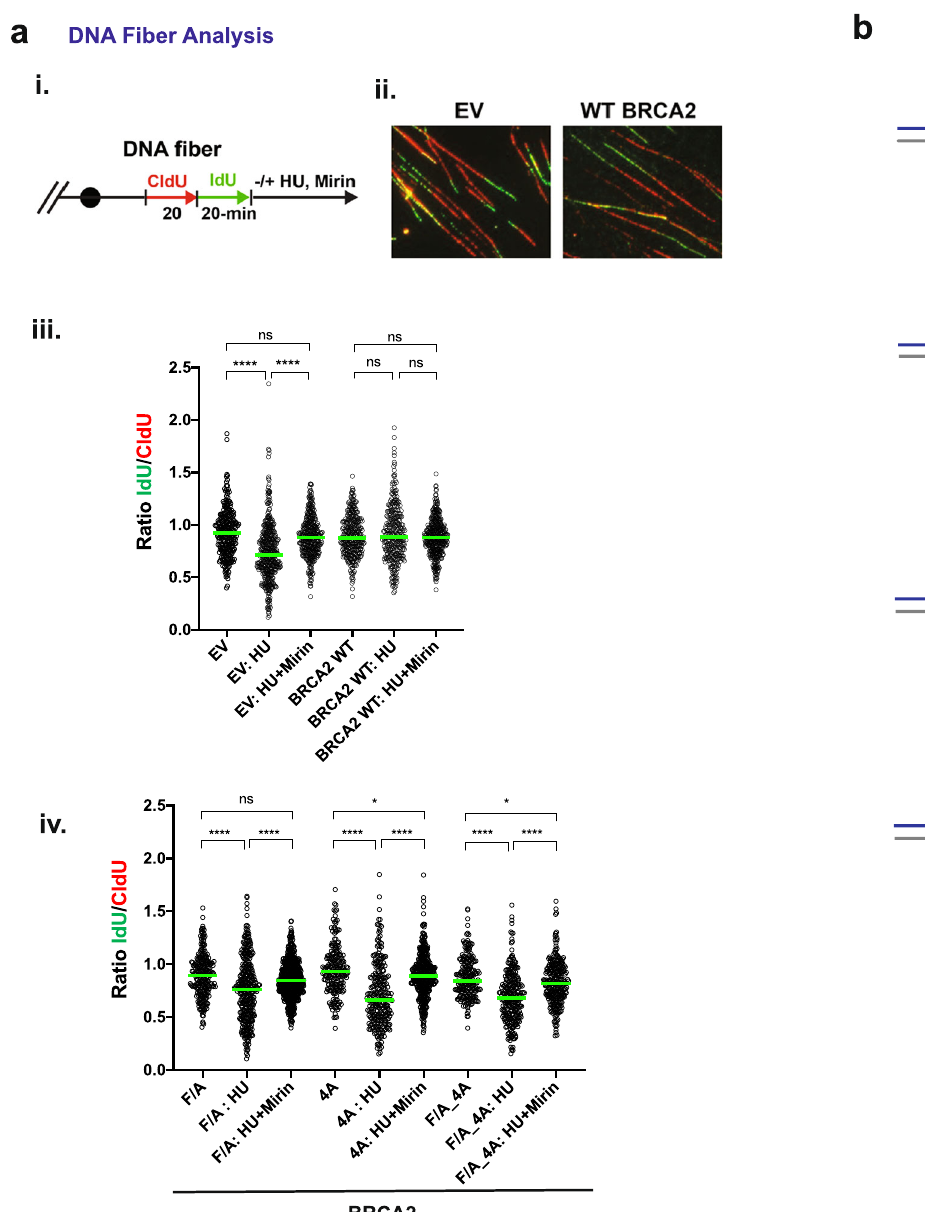
Fig. 6 | Signi fi cance of CTRB attributes in replication fork protection. a Schematicof DNA fi beranalysis( i )and representative micrographs ( ii ).Dotplots of IdU to CldU tract length ratios for individual replication forks in unperturbed, and HU-treated cells with or without mirin ( iii , iv ). The median value of 100 – 150 CldUandIdUtractsfromthreeandfourindependentexperimentsforunperturbed and treated cells, respectively, is indicated. Kruskal – Wallis test followed by Dunn ’ s multiple comparisons test. (ns (no signi fi cant difference): p ≥ 0.05; * p <0.05; **** p <0.0001. p value between the EV group and the EV: HU+Mirin group is